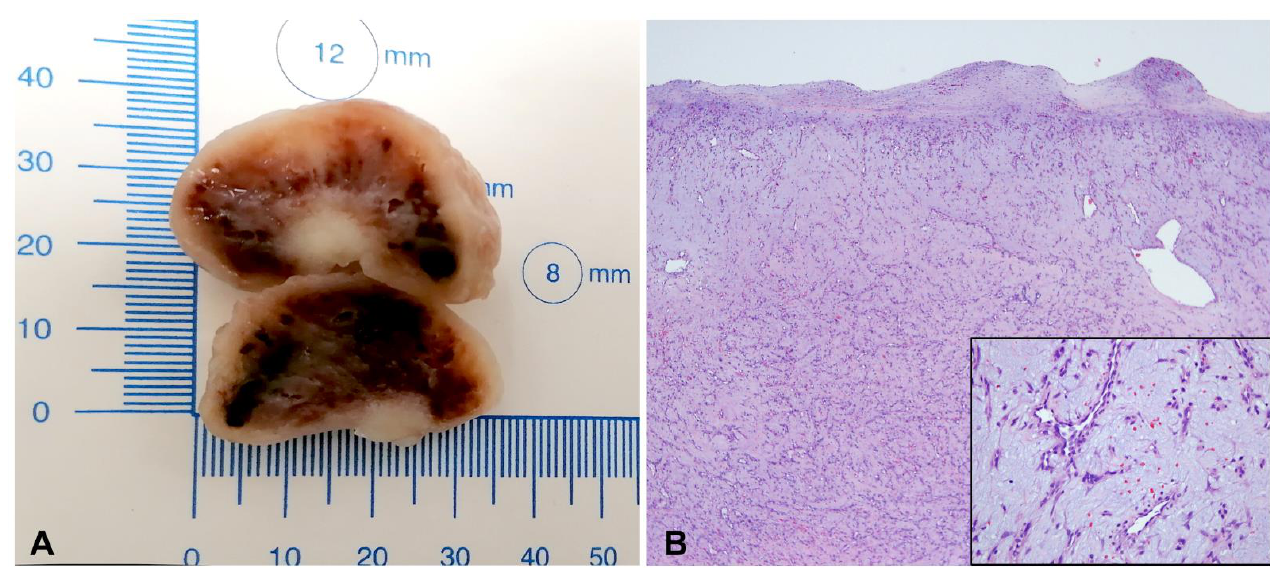
Figure 4. Computed tomography.